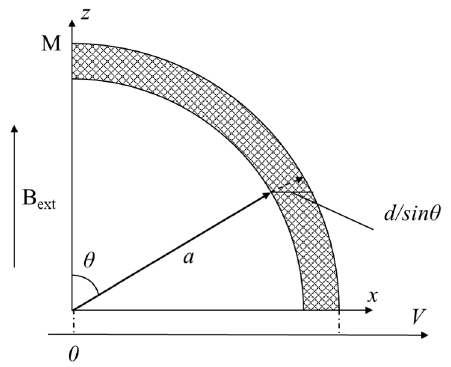
Figure 6. Fe 3 O 4 (Al) single particle model.